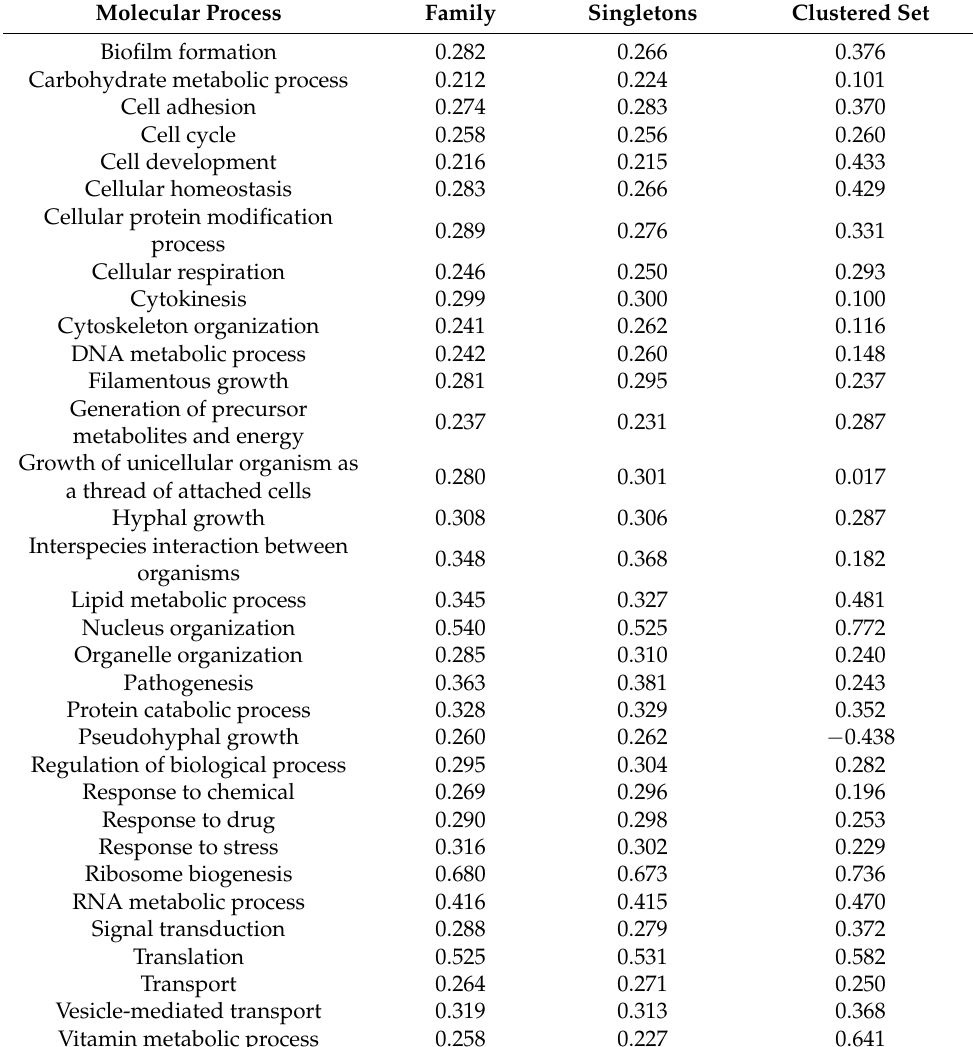
Table 2. Pearson’s Correlation Coefficient of Functionally Related